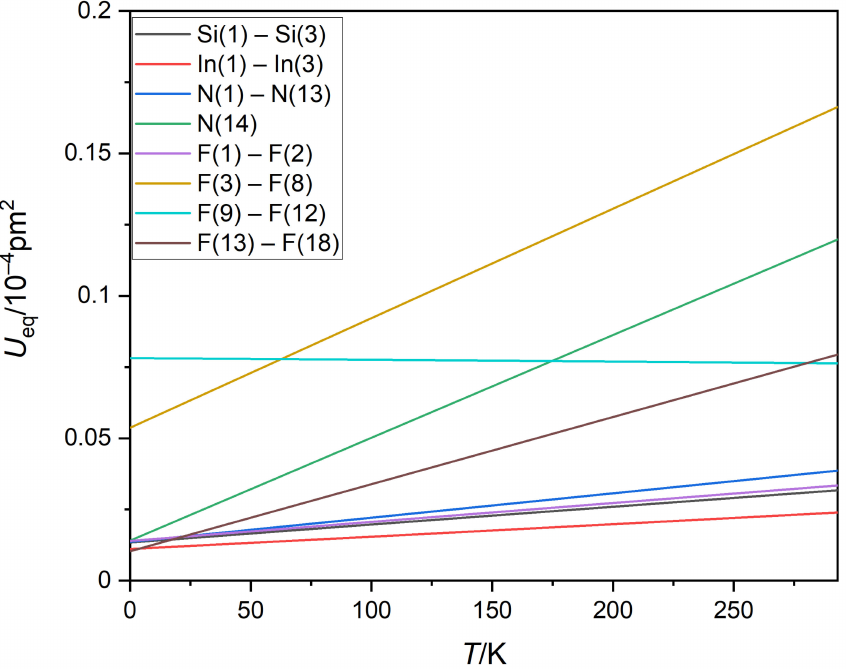
Figure 12. Extrapolation of U eq to 0 K, using data from single crystal diffraction experiments at 293 and 100 K, for the above-mentioned atom groups. The comprehensive extrapolation of U 11 , U 22 , U 33 , and U eq to 0 K can be found in Figure S2 and Table S6 in the Supplementary